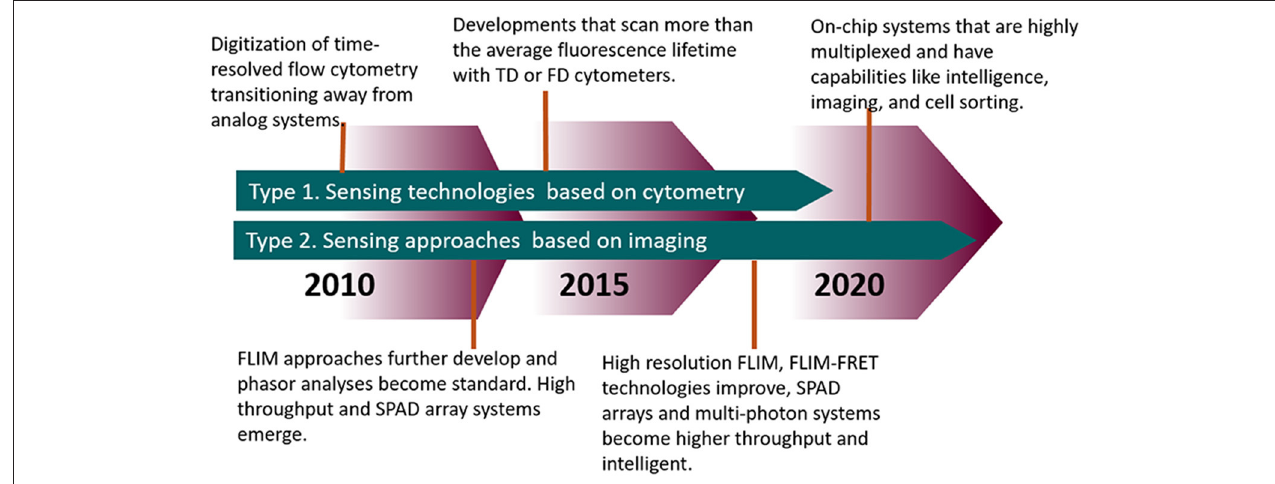
FIGURE 9 | Timeline highlighting the advances in FLIM and TRFC from the past decade and moving